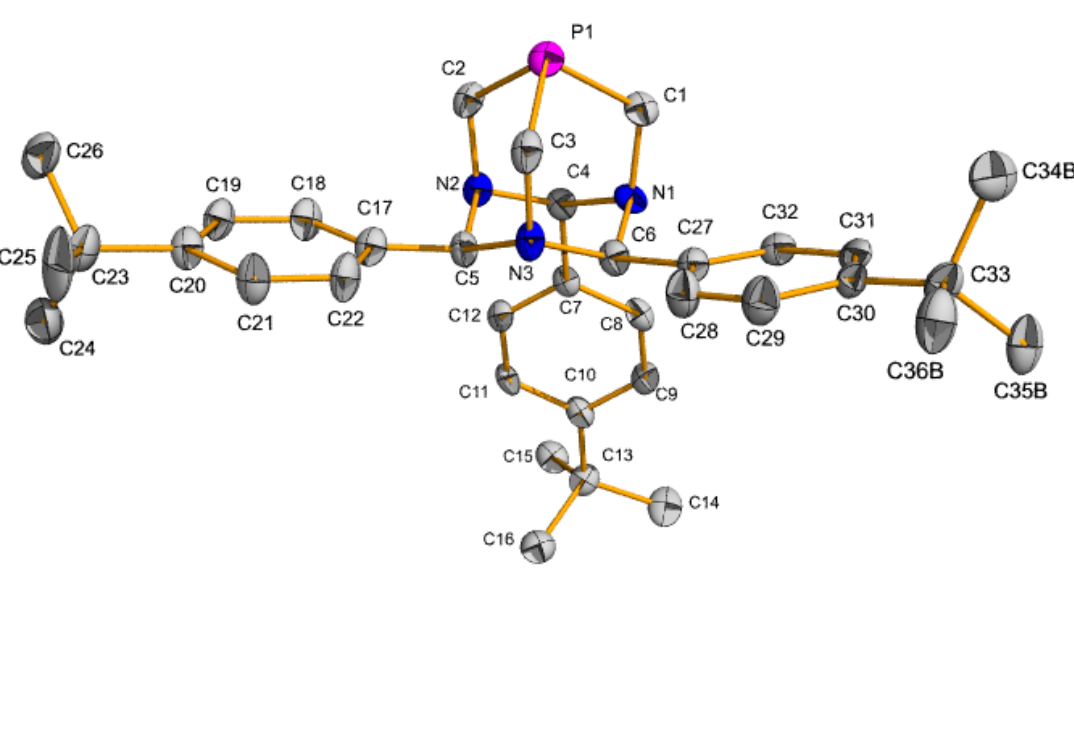
= 1.858(4), ave = ave